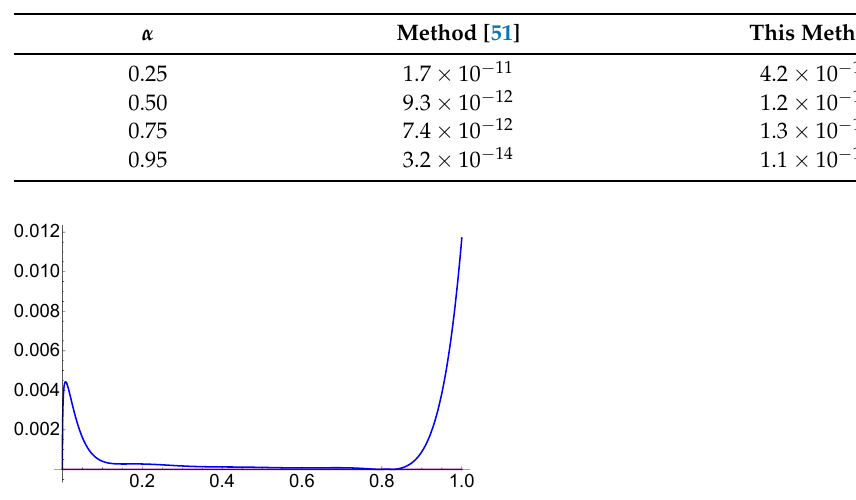
Table 3. Absolute errors for N = 1 and M = 16, α = q in Example 5.